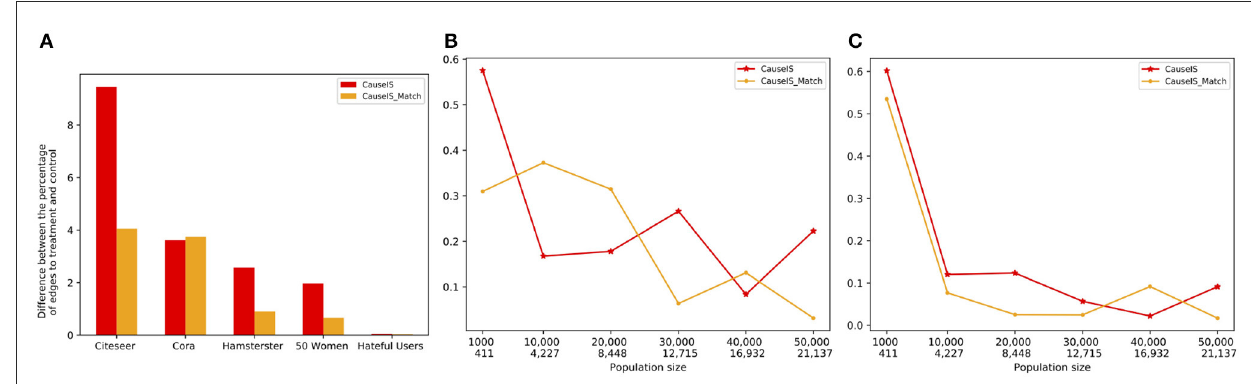
FIGURE8 Difference between the percentage of edges to treatment and control nodes in real-world and synthetic datasets with a different number of nodes and edges. In synthetic dataset plots, numbers in the first row of the x-axis show the number of nodes in graphs, and in the second row show the size of MIS. (A) Real-world data, (B) Forest Fire model, and (C) Barab’asi-Albert model.